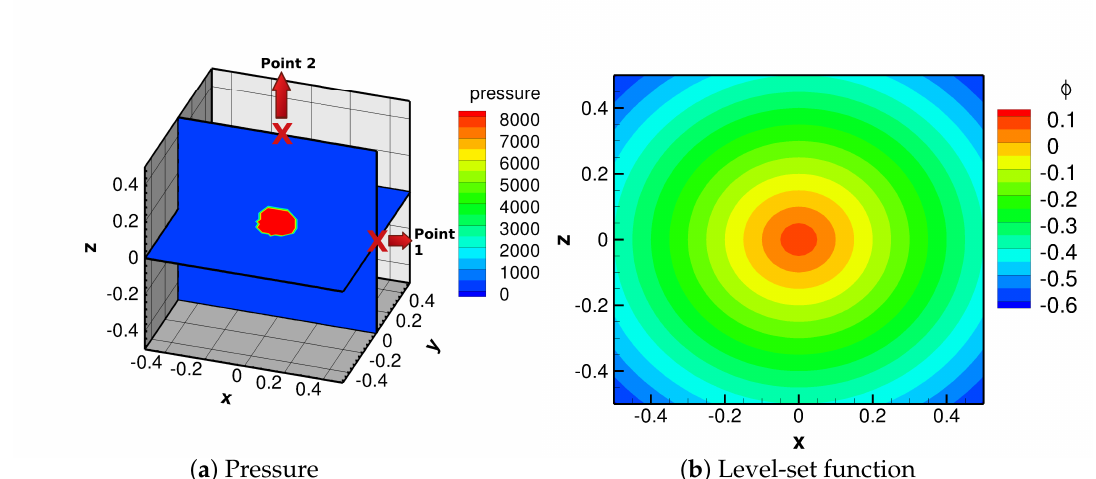
Figure 1. The initial setup of the underwater explosion (UNDEX) simulation with a high-pressure gas bubble in a spherical shape. ( a ) the initial distribution of the pressure, shown in a slice plot (surfaces y = 0 and z = 0). Two recording points, Point 1 with the position (0.5, 0.0, 0.0) and Point 2 (0.0, 0.0, 0.5) were placed at the boundaries of the computational domain; ( b ) a 2-D plot of the initial level-set function φ in the x – z surface ( y =